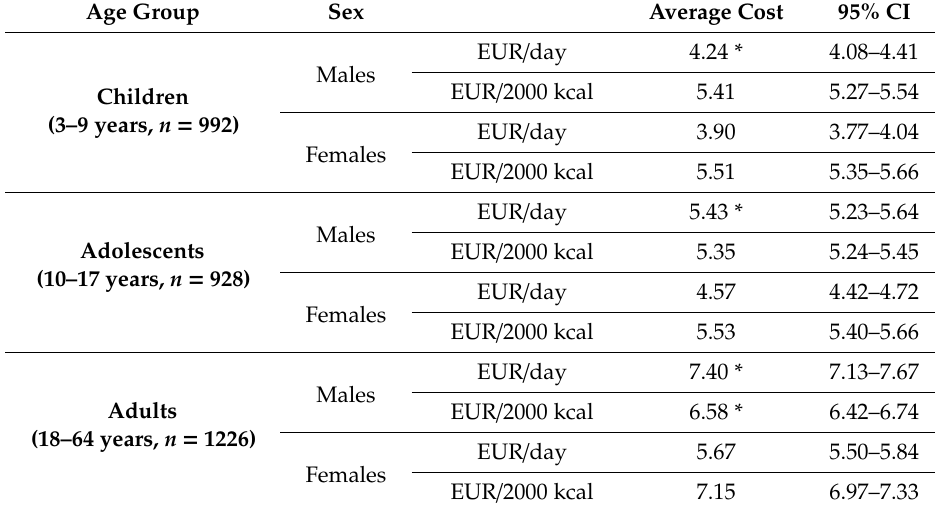
Table 1. Average total cost per day and average cost per 2000 kcal (including alcohol) for di ff erent age groups by sex in Belgium (Belgian national nutrition survey 2014 /